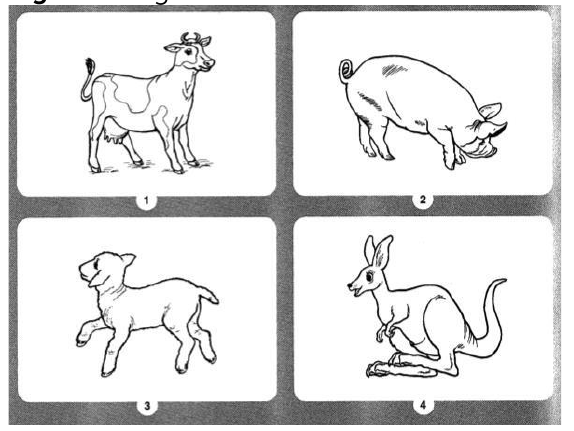
Figure 5 Image from the Test de Vocabulario en Imágenes